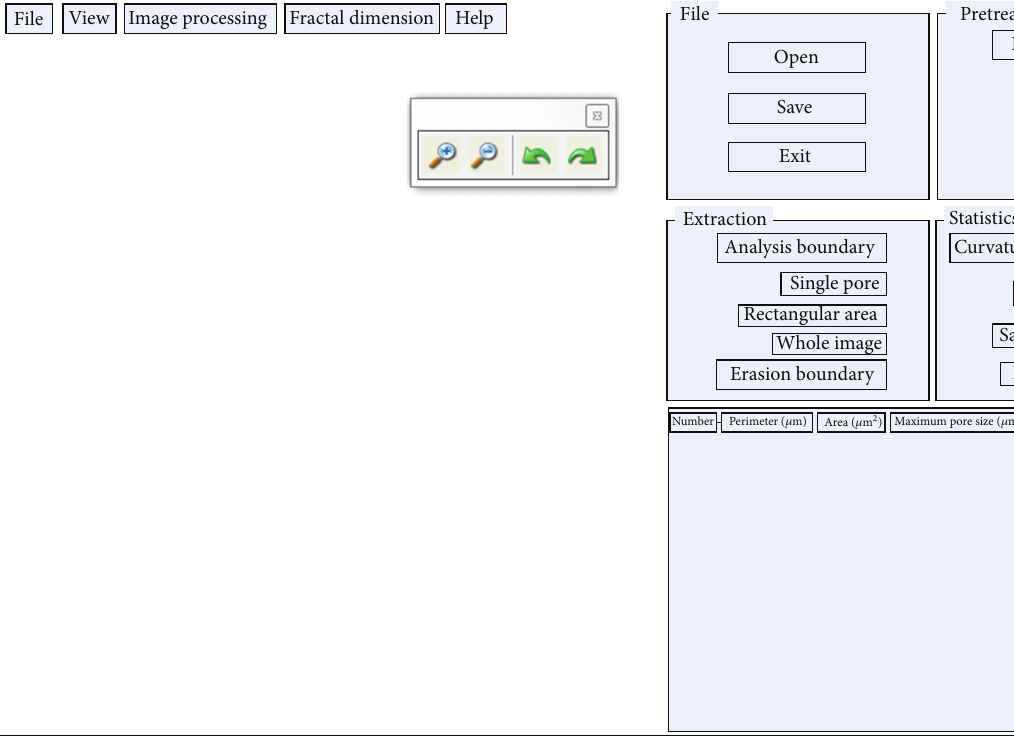
Figure 1: Layout view of software.